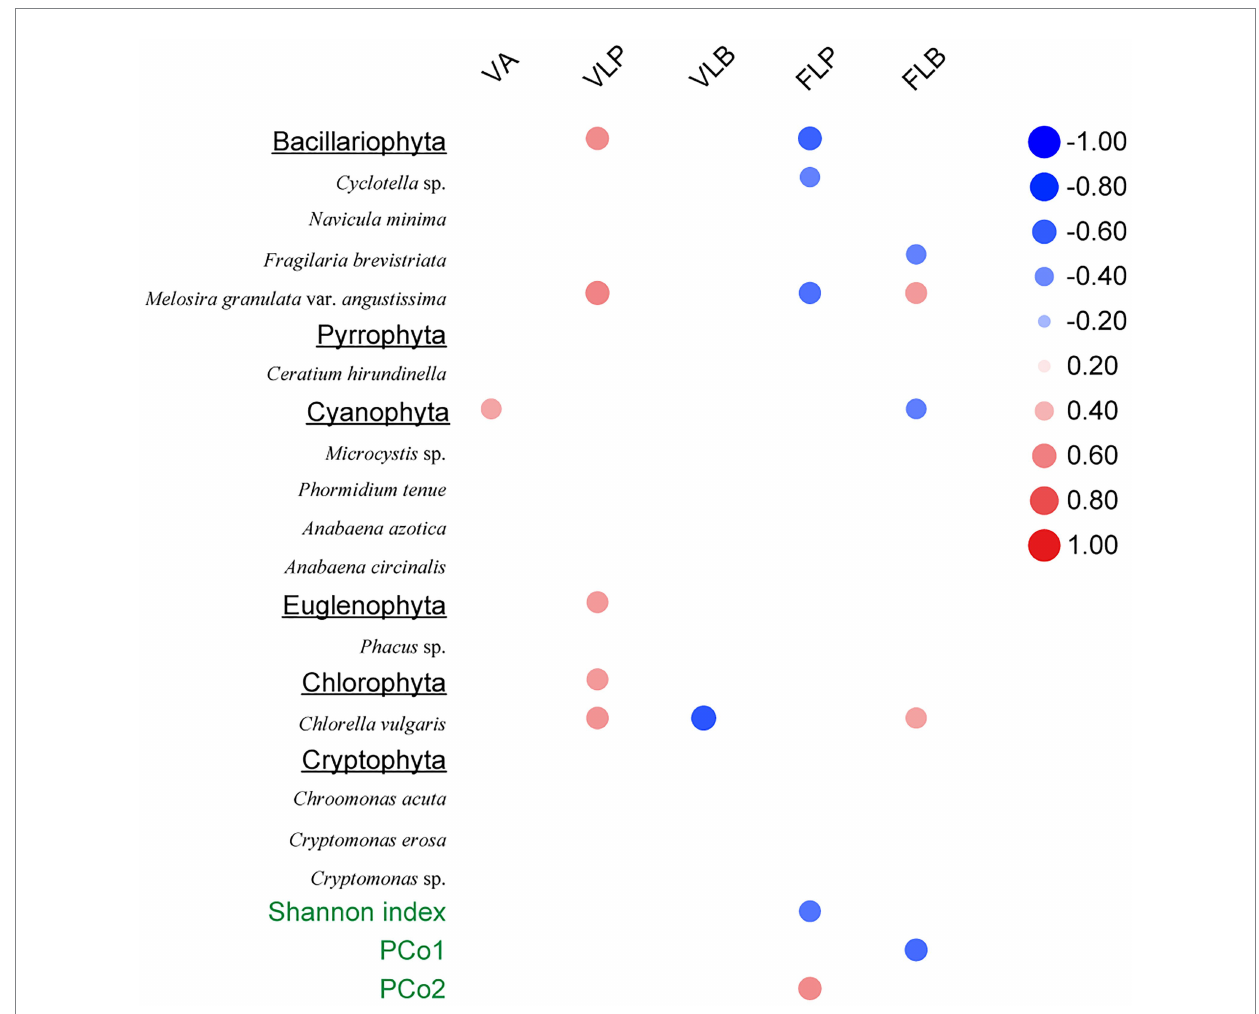
FIGURE 6 Spearman rank correlations between viral-related variables and the phytoplankton community composition. Only statistically significant ( p < 0.05) correlations are shown. Right column data represent correlation coefficient.